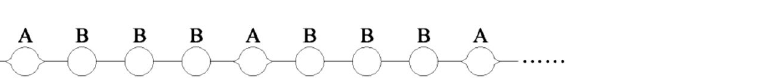
Figure 10. TSC fracture blasting circuit for PBH